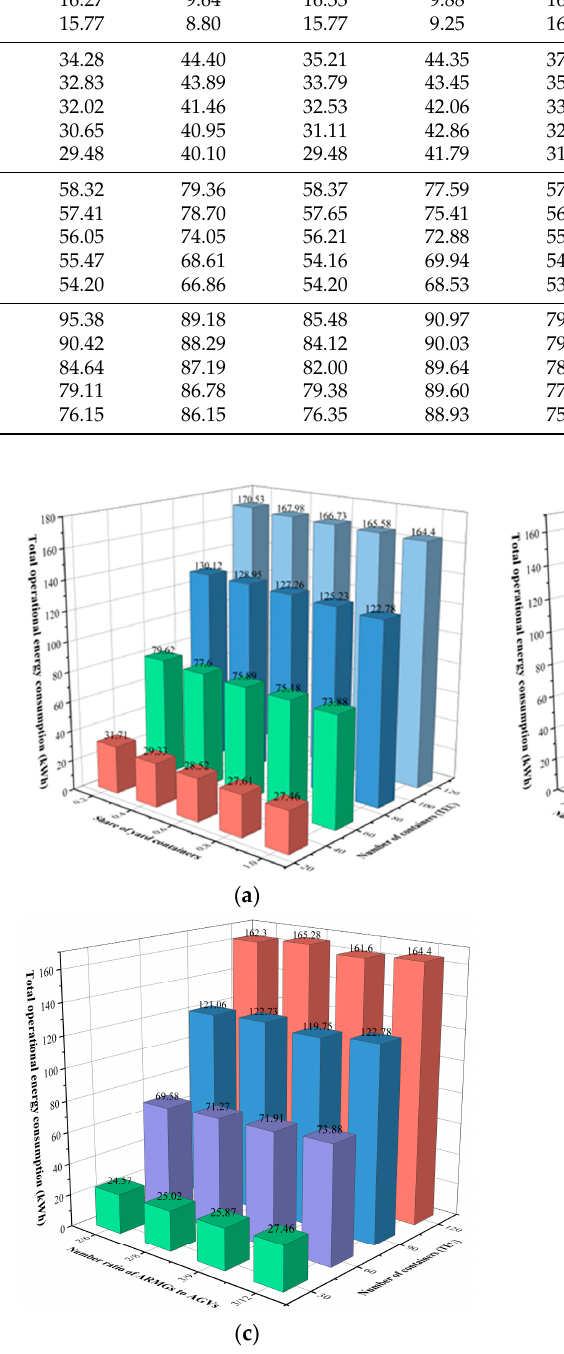
Figure 13. ( a ) Variation in energy consumption for different containers and ratio of “transshipment” containers with 3 ARMGs and 12 AGVs; ( b ) Variation in energy consumption for different contain- ers, ARMG, and AGV configurations with all “transshipment” containers; ( c ) Incremental energy consumption for yard containers ratios and different ARMG to AGV ratios for 120 TEU.